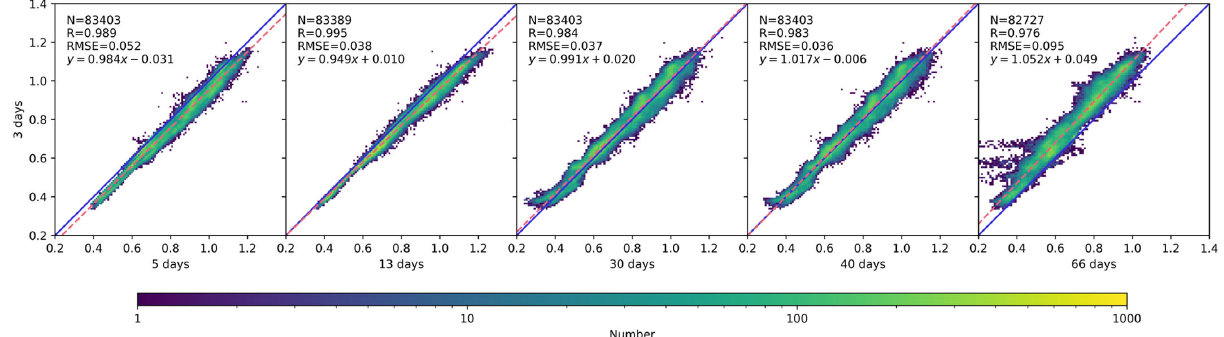
Figure 8. The sca tt er plots between the AOD values based on the closest reference image (3 days) in time and that based on other reference images (more than 3 days).